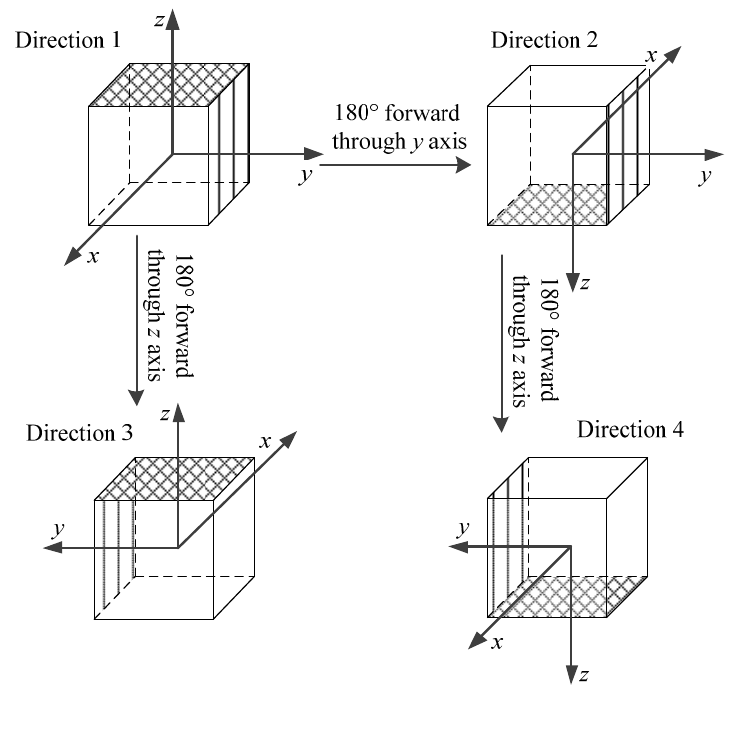
Figure 4. Rotation directions for installation error